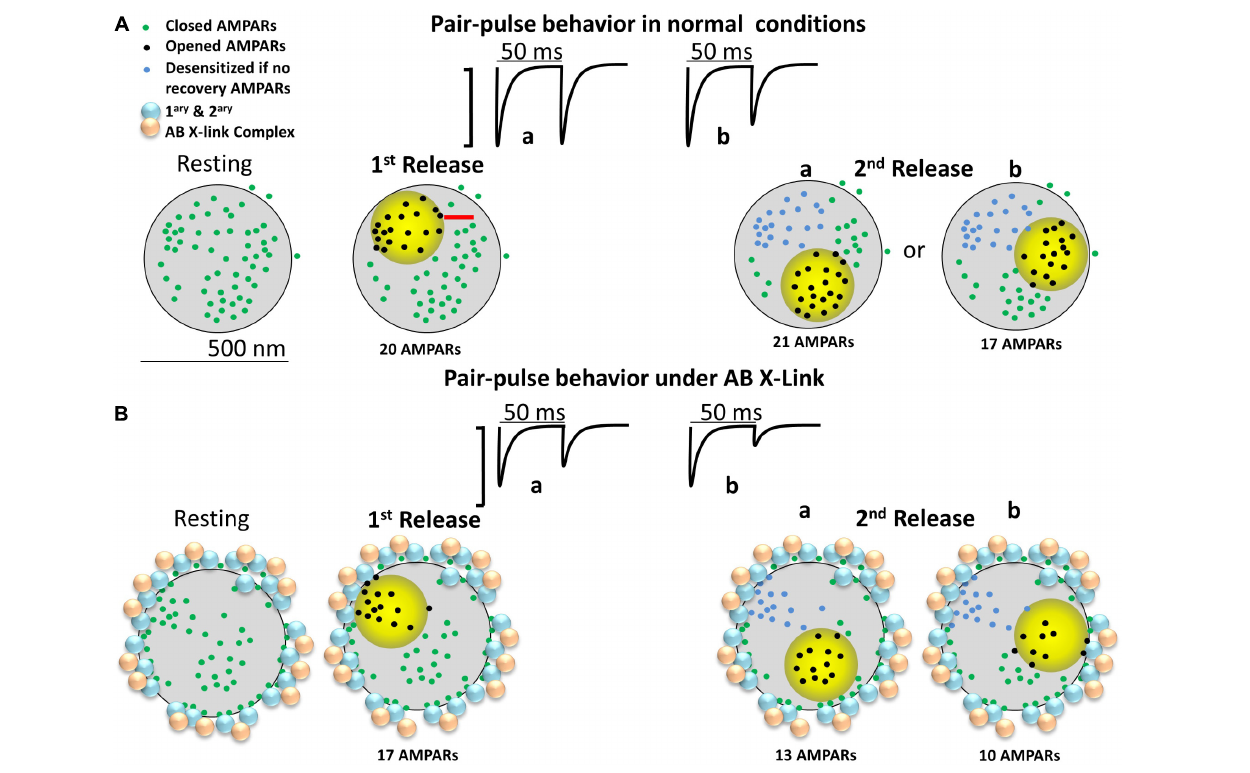
FIGURE 4 | Diagram of a large mushroom spine with realistic AMPAR content randomly distributed thought the space as shown by Shinohara and Hirase (2009). Zone of high glutamate concentration is illustrated by the yellow circle. Three different states for AMPAR are assigned: closed (green color), opened (black), and desensitized (blue). AB X-ling complex is depicted by solid gold and blue particles. (A) Control synapse. Three states are shown: resting (left), 1st pulse (middle left), and two possible sites for the 2nd release (right a and b). Response for paired-pulses is shown above. Estimated synaptic response is shown above as a one to one correspondence between number of AMPAR and size of response. (B) The cross-linking synapse. The AB particles decorate the perisynaptic area. AB complexes induced redistribution of AMPARs is shown.